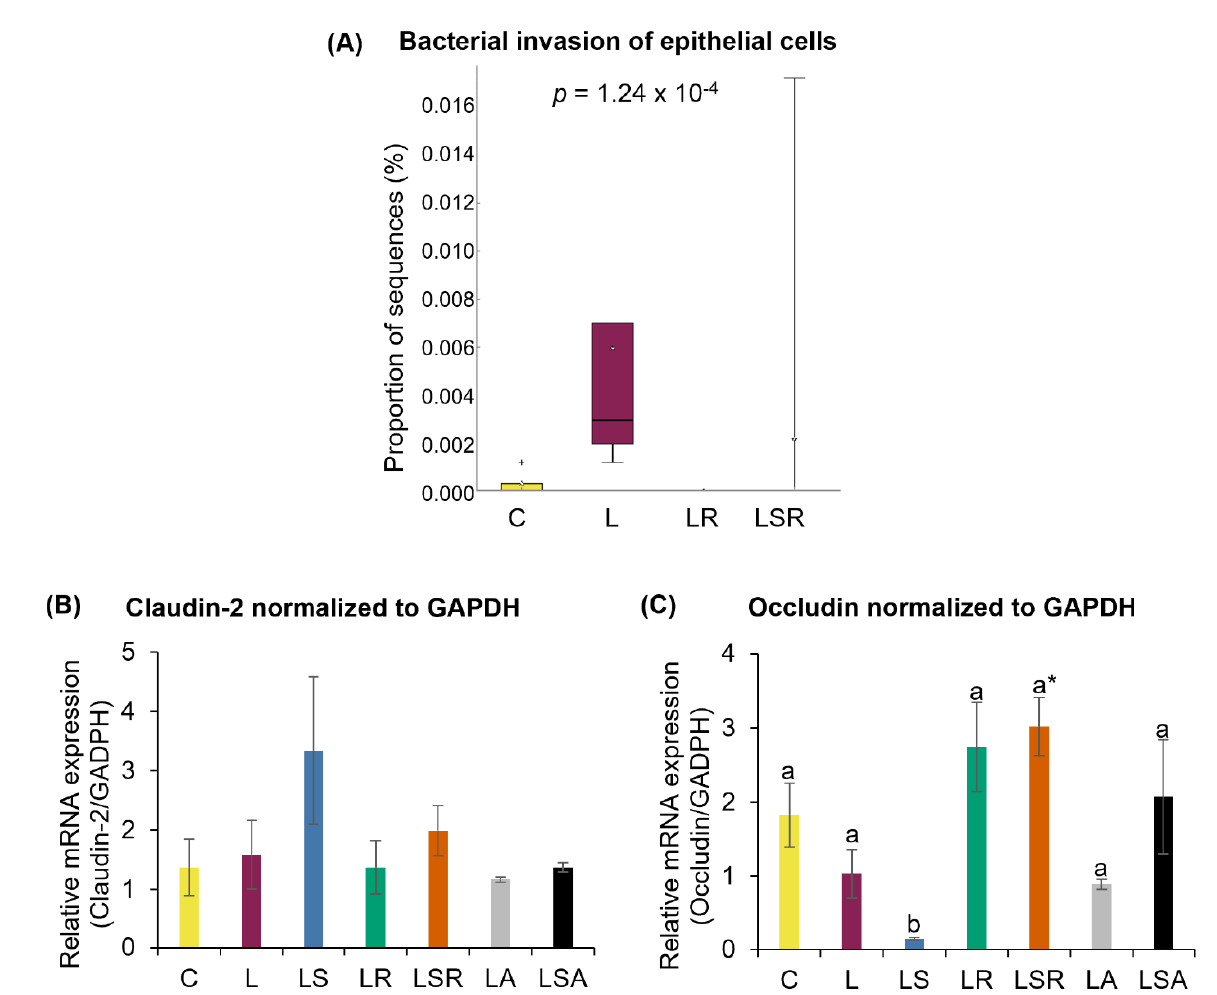
Figure 7. Analyses of gut barrier markers. ( A ) Relative abundance of microbial functional pathway responsible for bacterial invasion of epithelial cells. This analysis was performed by evaluating the differences in the function of the microbial communities ascertained from 16S rRNA sequencing using PICRUSt software. Relative mRNA expression of gut barrier markers; ( B ) claudin-2 and ( C ) occludin. The expression levels of the genes in the colon samples were measured using quantitative RT-PCR. GAPDH was used as a loading control to normalize each sample. All the values are expressed as the mean ± S.E. Statistical analysis of bacterial sequences was conducted by Kruskal – Wallis test followed by Tukey – Kramer test for multiple comparison analysis. Statistical analysis of other parameters was conducted by one-way ANOVA followed by Dunnett’s test for multiple comparison analysis. a, b represent p < 0.05 compared to the C group, * represent p < 0.05 compared to the L group.